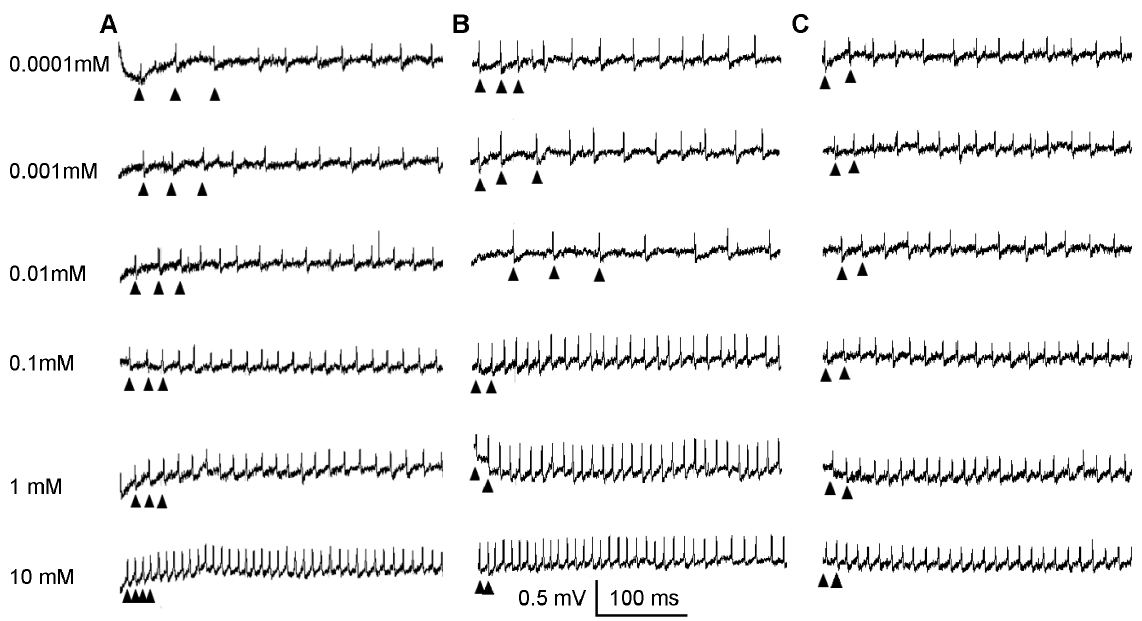
Figure 4. A. Representative traces of responses elicited by the deterrent-sensitive neuron in the medial styloconic sensilla to increasing concentrations of (A) IR3535 (B) Picaridin and (C) DEET. Up-arrowheads represent the response of the large-amplitude deterrent-sensitive neuron.